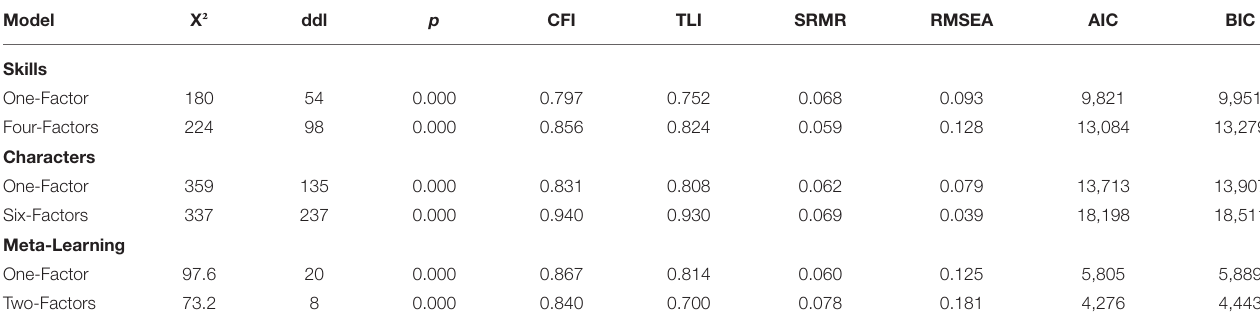
TABLE 7 | Confirmatory factor analysis on CCI21-36.